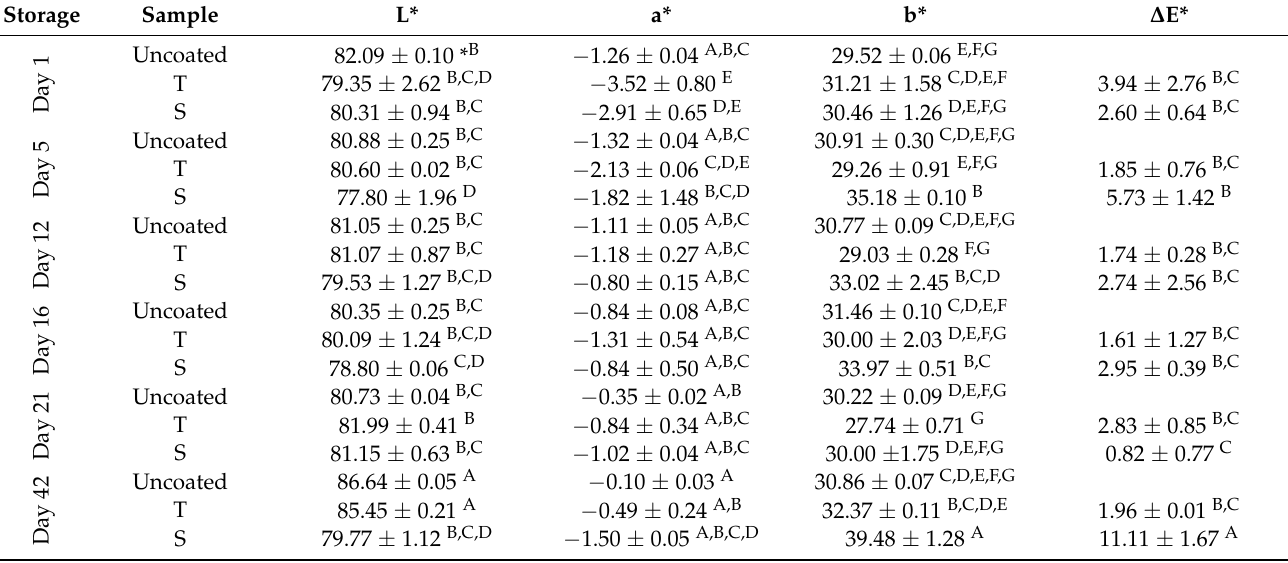
Table 4. Color evaluation of zucchini pulp during 42 days of